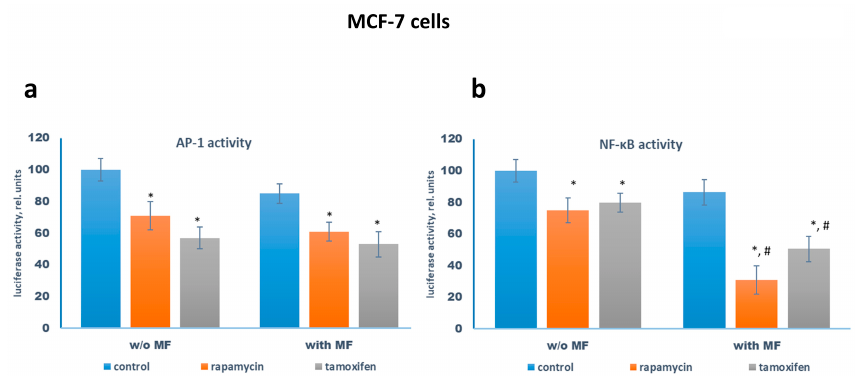
Figure 2. Reporter analysis of the transcriptional activity of AP-1 and NF- κ B in the MCF-7 cells. The MCF-7 cells were pretreated with or without 2 mM metformin for 2 days, then the cells were transfected with the AP-1 ( a ) or NF- κ B ( b ) plasmid containing the luciferase reporter gene under the AP-1 or NF- κ B-responsive elements, respectively, and β -galactosidase plasmid. Three hours after transfection the cells were treated with or without 1 µ M rapamycin, 2 mM metformin (MF), and 5 µ M tamoxifen for 24 h. The luciferase and β -galactosidase activities were determined as described in Materials and Methods. The relative luciferase activity was calculated in arbitrary units as the ratio of the luciferase to the galactosidase activity. Data represent the mean value ± SD of three independent experiments. p < 0.05: * versus respective control, # versus respective probes w / o metformin. Pharmaceuticals 2020 , 13 , x FOR PEER REVIEW